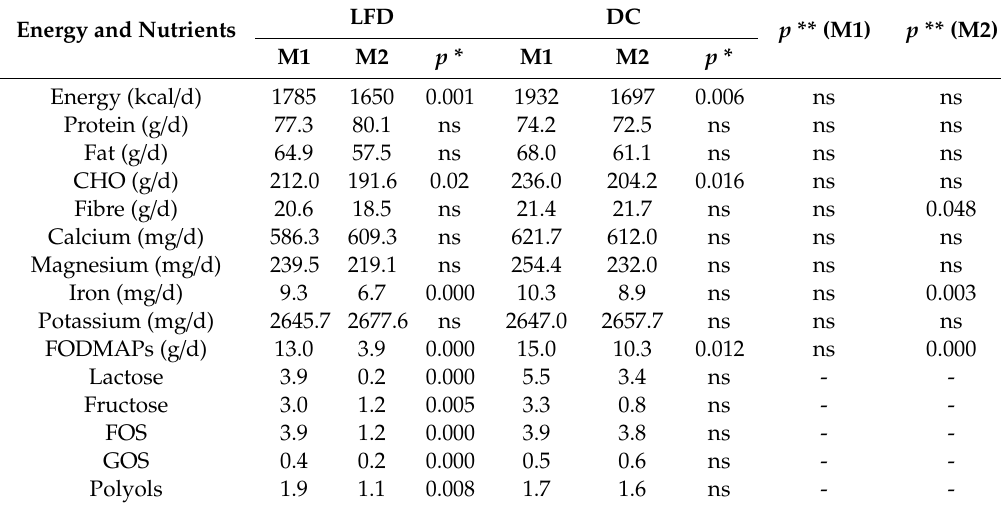
Table 3. Nutritional Intake.